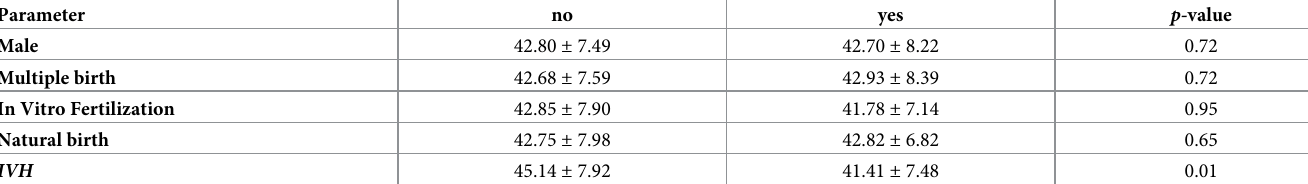
Fig 3. Calculated total cerebral resistance (a) and CBF (b) versus gestational age for different values of systemic hematocrit. The red lines show the values calculated using the constant blood viscosity μ = 0.003 Pa � s . https://doi.org/10.1371/journal.pone.0261819.g003 Table 3. Dependence of the hematocrit on basic demographic characteristics and IVH diagnosis.